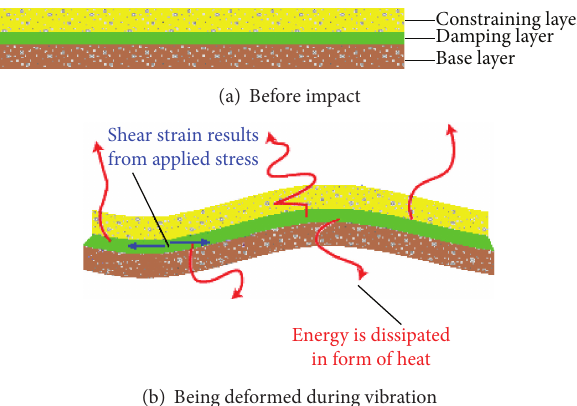
Figure 3: Working principle of a constraining damping treatment system.